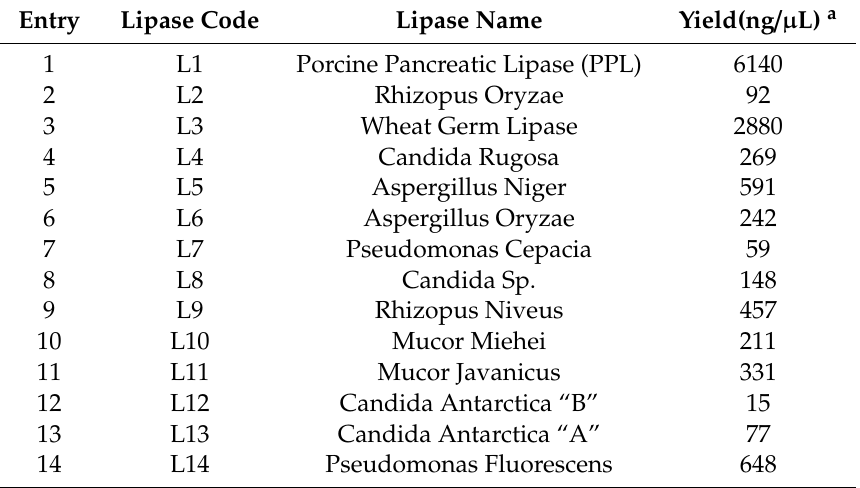
Table 1. Screening of lipase library for synthesis of Wieland–Miescher ketone.